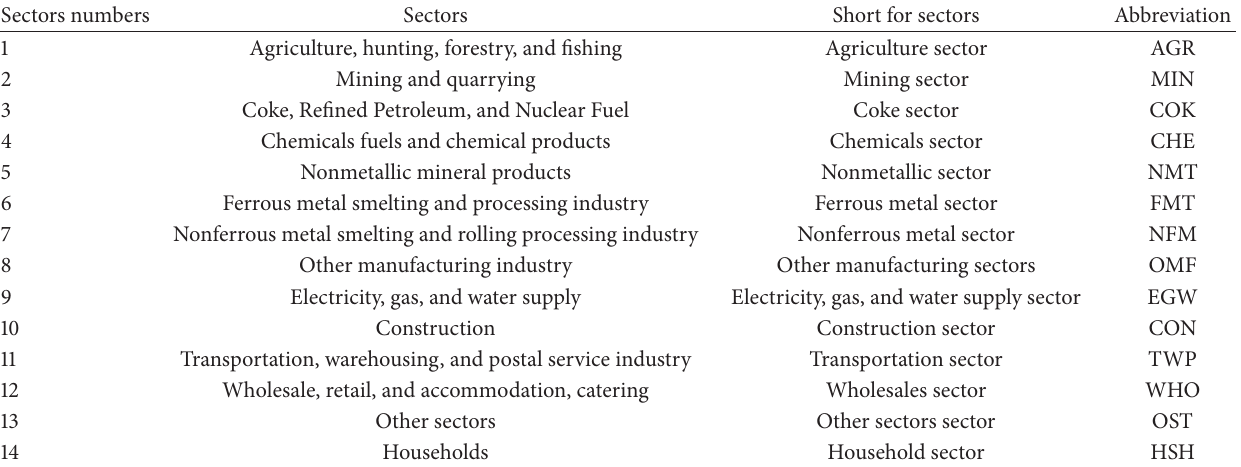
Table 1: Sector classification and abbreviations.